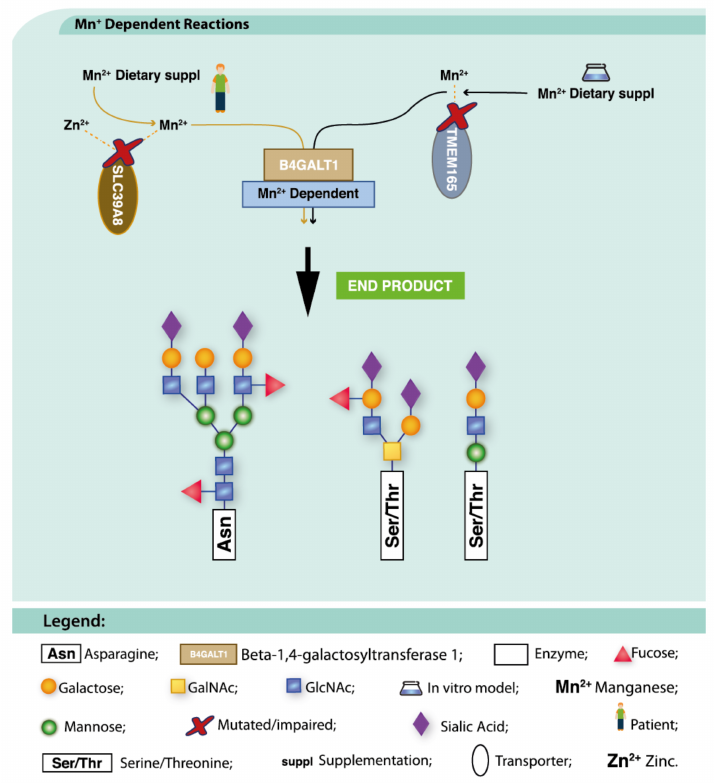
Figure 5. Dietary supplementation approaches under investigation for TMEM165-CDG and SLC39A8-CDG. Impaired transport of metal ions (dotted yellow lines), can be circumvented by Mn 2+ supplementation (yellow and black lines). These therapeutic approaches aim to recover the metabolic pathways (black arrows) and ultimately, the final end product (bold black